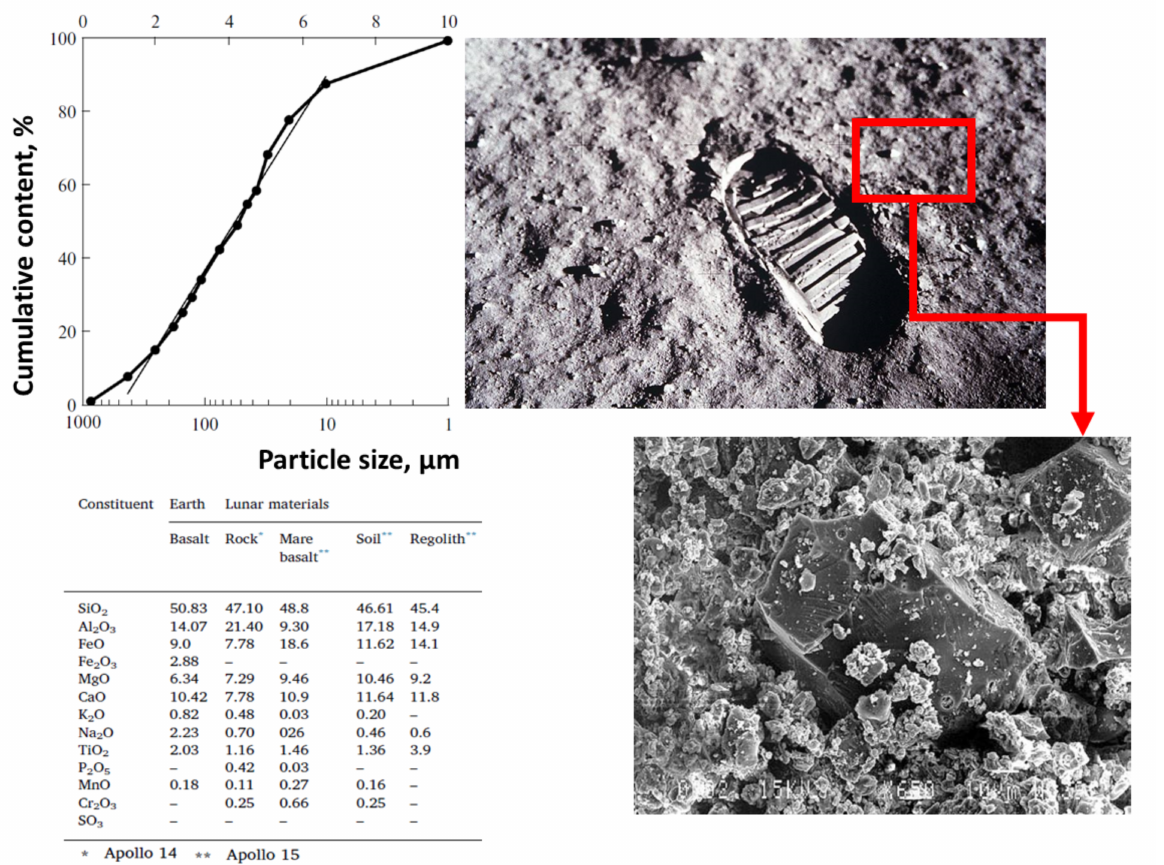
Figure 2. Morphology, particle size distribution (PSD) plot, and chemical composition of the lunar regolith (based on